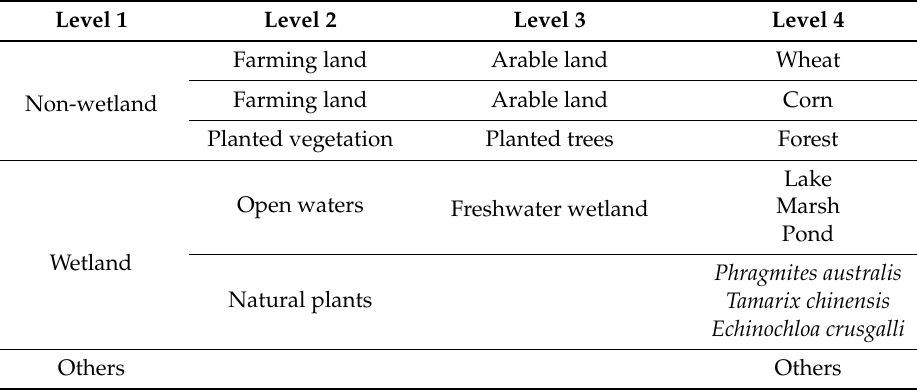
Table 1. The wetland classification system for the study